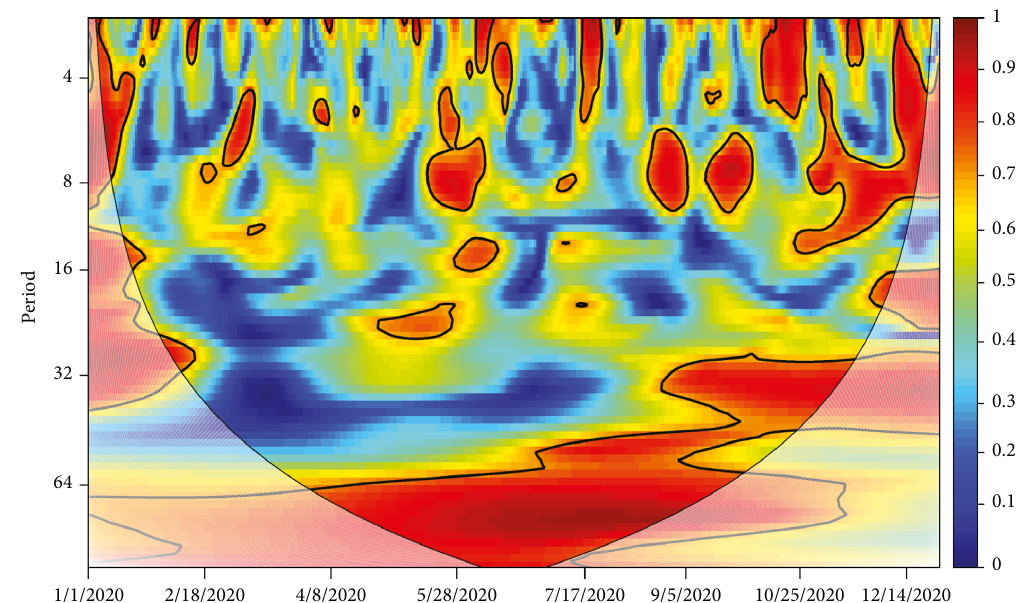
Figure 5: The combined effects of EPU and IDEMV on illiquidity (tranquil period). Note: this figure reports the combined effect of EPU and IDEMV on illiquidity during tranquil period. The black contour represents the regions in which the spectrum is significant at the 5% level against red noise. The cone of influence denoted as COI is designated by the lighter shade which delineates the high power regions. Time and scale (days) are represented on the horizontal and vertical axes, respectively. Arrows pointed to the right (resp. left) signify that the variables are in phase (out of phase). If arrows move to the right and up (resp. down), the first variable is the driver (resp. follower). By contrast, if arrows move to the left and up (down), the second variable is leading (resp.